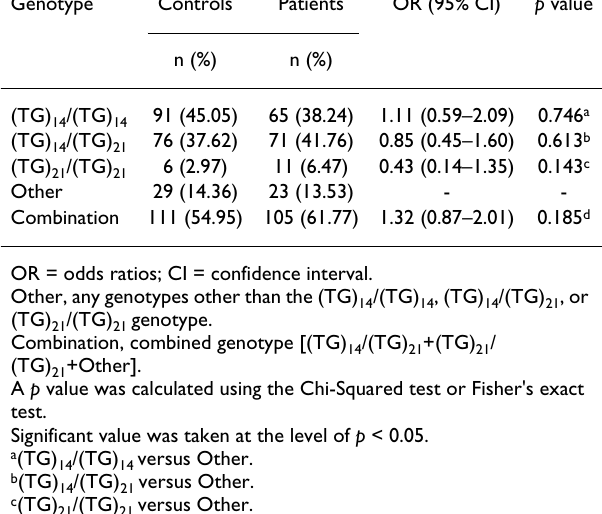
Table 3: Genotype frequency of the Flt-1 (TG) n polymorphism in normal controls and preeclamptic patients